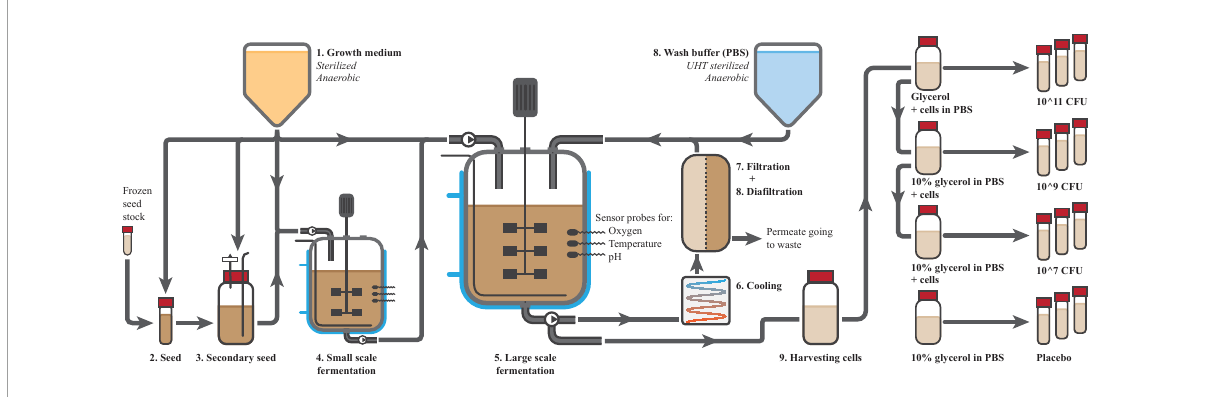
FIGURE3 Preparation of Anaerobutyricum soehngenii. Production started with the production of a sterile anoxic growth medium (1), which was used for the seeding (2 and 3) and fermentations (4 and 5) of A. soehngenii . The fermentations were well controlled for temperature, presence of oxygen and pH amongst others. After the final fermentation, cells were cooled (6), concentrated (7) and washed by diafiltration (8). Cells were harvested from the fermenter (9), diluted with glycerol (10% final concentration) to 10 10 CFU/ml and dispensed over 10 ml vials that were labeled and directly frozen. The highest concentration was used to make dilutions for the lower doses.